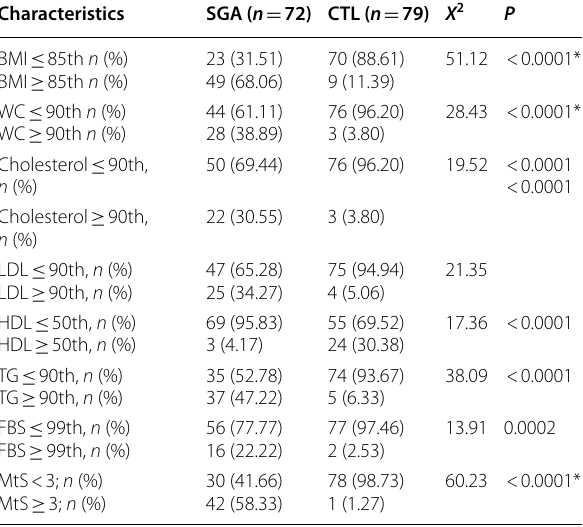
Table 2 Distribution of patients according to BMI, waist circumference percentiles, serum lipids, glucose percentiles and metabolic syndrome score